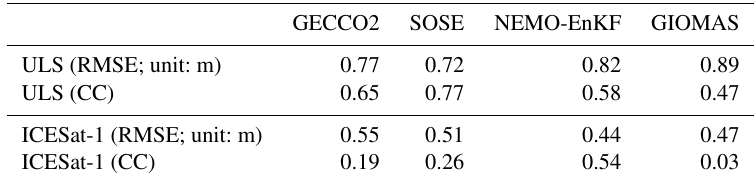
Table 5. Statistics of the four reanalyses with respect to ULS and